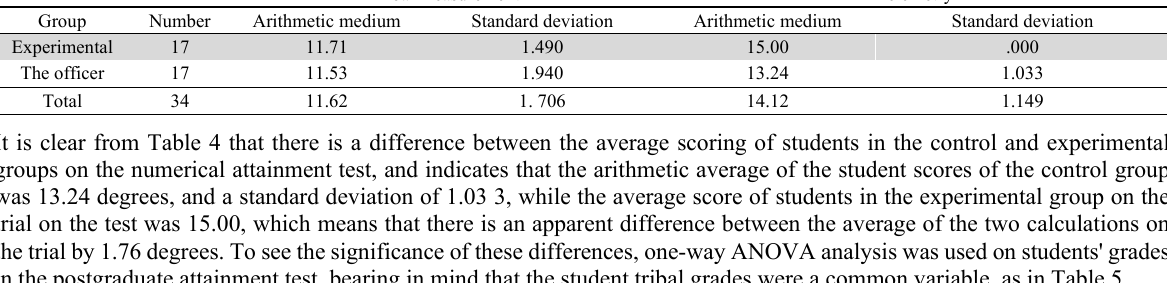
Computational averages and standard deviations Tribal measurement Telemetry Group Number Arithmetic medium Standard deviation Arithmetic medium Standard deviation Experimental 17 11.71